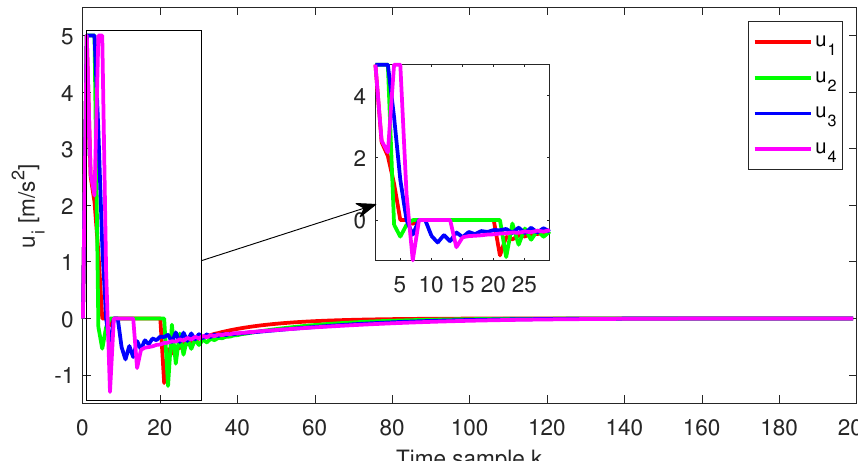
Figure 9. Test 8 —Acceleration for each platoon vehicle.